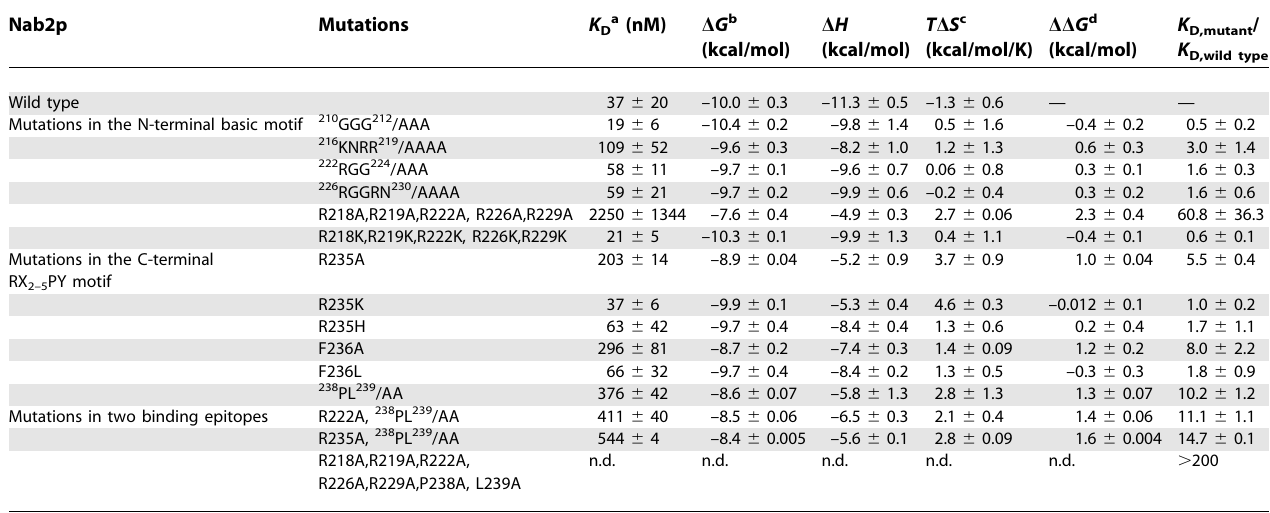
Table 3. Summary of ITC Data for Kap104p Binding to Nab2p Mutants